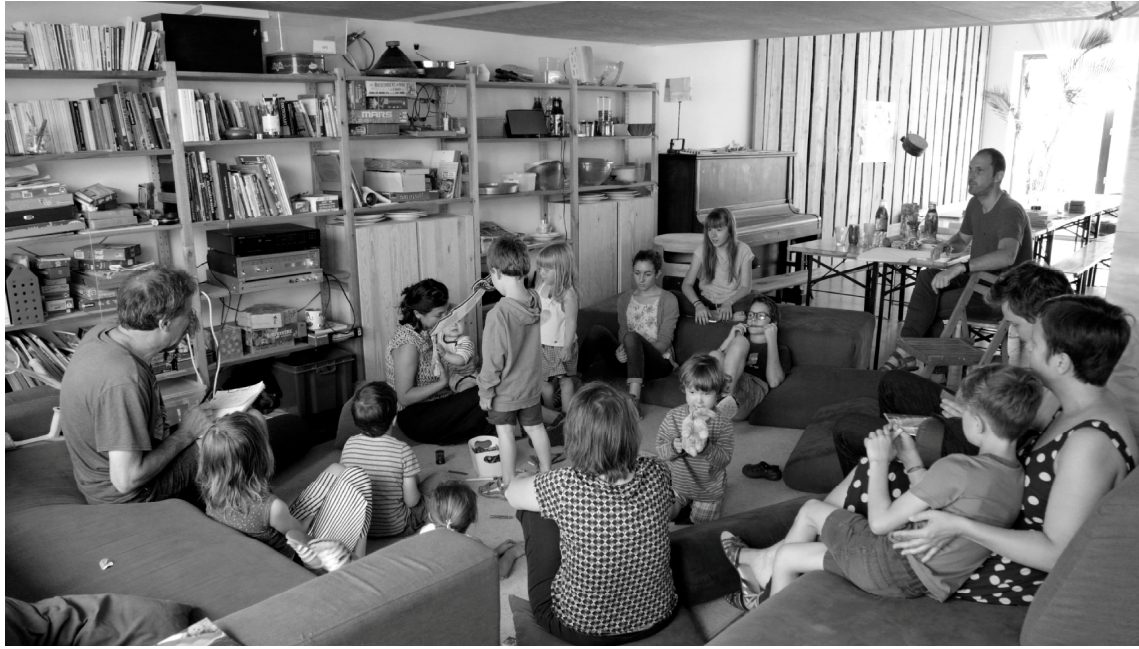
Figure 9. Children gathering in the collective room (source: Matthieu Liétaert, 2018).